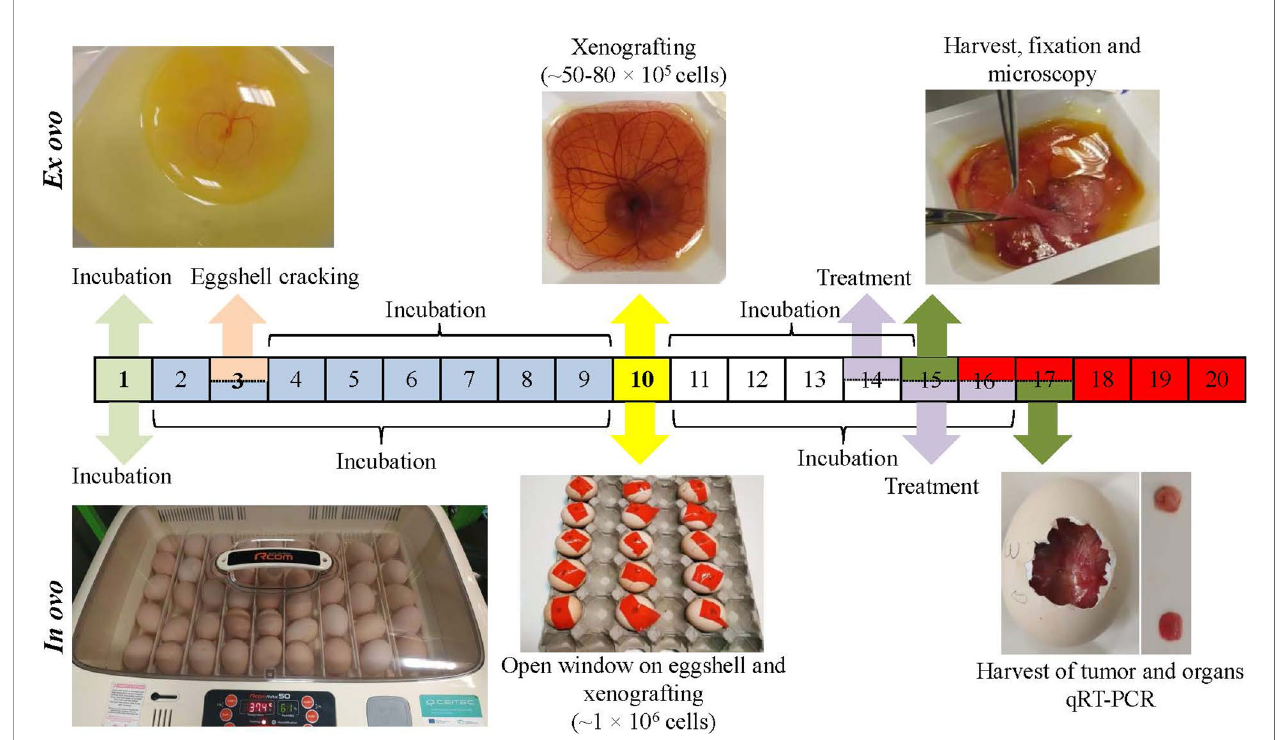
FIGURE 1 | Work fl ow of ex ovo and in ovo chick chorioallantoic membrane (CAM) assays for development of neuroblastoma (Nbl) xenograft using UKF-NB-4 cells. For ex ovo CAM assay, the fertilized eggs were incubated for 3 days. Then, the eggshell was cracked, and the content was transferred into sterile dishes followed by incubation (additional 6 days). Nbl cells were then grafted on the CAM (speci fi cally on vascular branches), and the embryos were incubated (additional 4 days). CAM areas with microtumors were extracted, keeping a 1-cm margin of healthy tissue, and were fi xed. For in ovo CAM assay, the fertilized eggs were incubated for 10 days. In the eggshell, a window was opened, and Nbl cells were xenografted. The eggs were incubated for additional 6